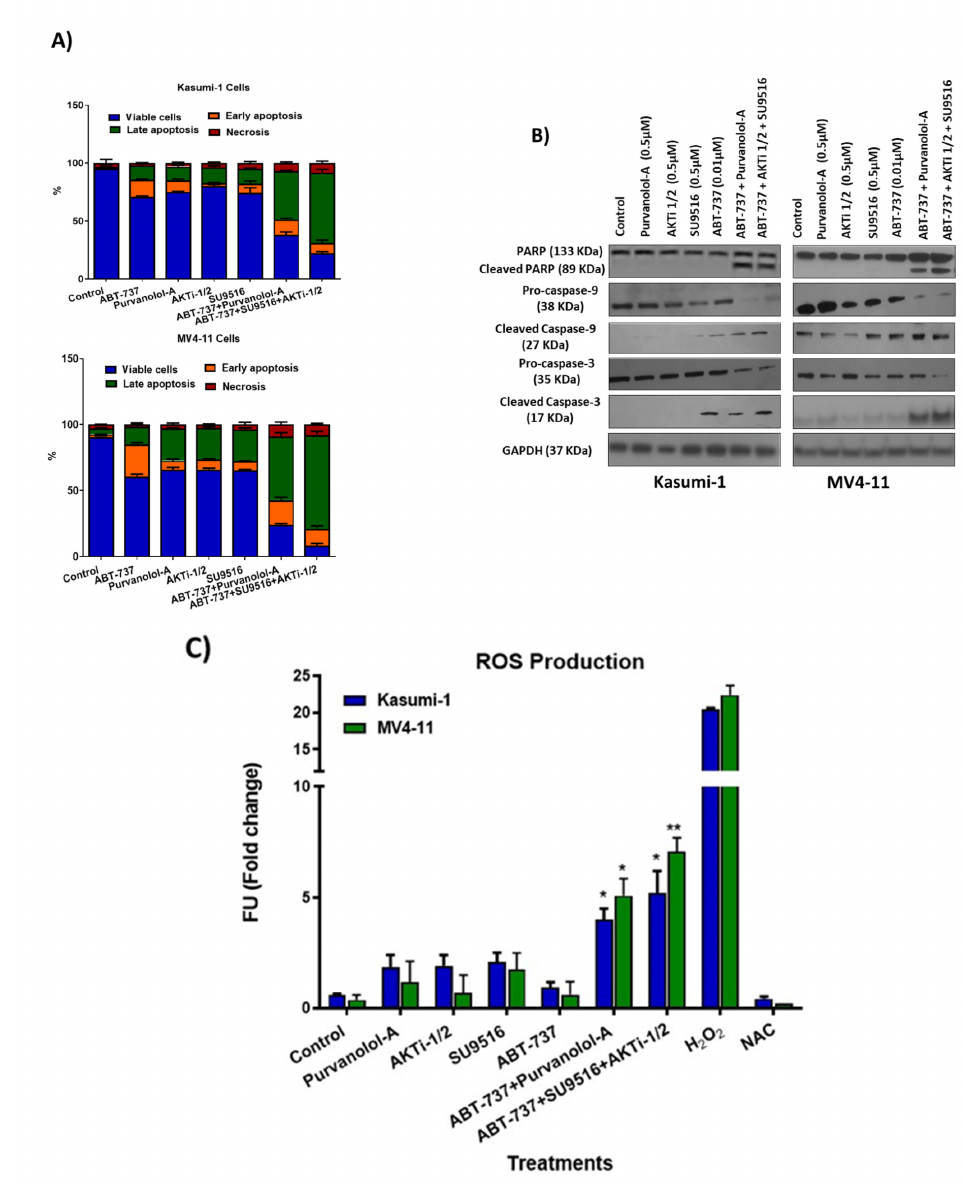
Figure 3. Validation of double and triple combinations in the paediatric AML cell lines. ( A ) Flow cytometry analysis of the annexin V-positive cell population for Kasumi-1 and MV4-11 cells following 72 h treatment as single agents and as a combination. ( B ) Western blot analysis of PARP, cleaved-PARP, procaspase-9, cleaved caspase-9, procaspase-3, and cleaved caspase-3 in Kasumi-1 and MV4-11 cell lines following 72 h treatment as single agents and as a combination. GAPDH was used as a loading control. All results shown are representative of three independent experiments. ( C ) Reactive oxygen species quantification following 72 h treatment as single agents and as a combination. Stained cells were analysed for fluorescence, measured using a Synergy HTX Multi-Mode Micro-Plate reader. We used 5 mM H2O2 and 5 mM N-acetyl cysteine (NAC) anti-oxidant as positive and negative controls respectively. * = p < 0.05, ** = p < 0.005 values of significance of treatments compared to controls were calculated using the paired t